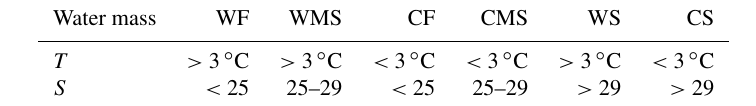
Table 1. The temperature and salinity of six defined surface water masses of the Laptev Sea using satellite data (see the text for the explanation of water masses names).